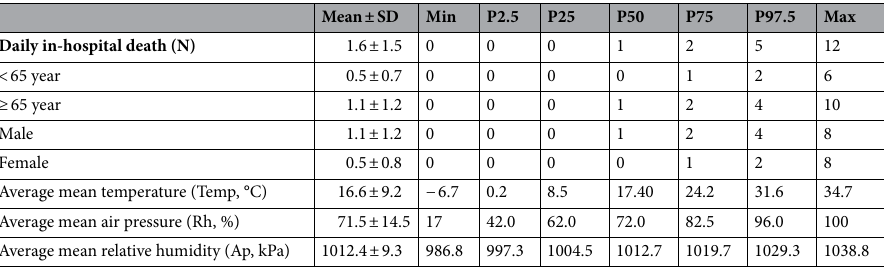
Table 1. Summary statistics of in-hospital deaths and climatic variables, 2010–2020.